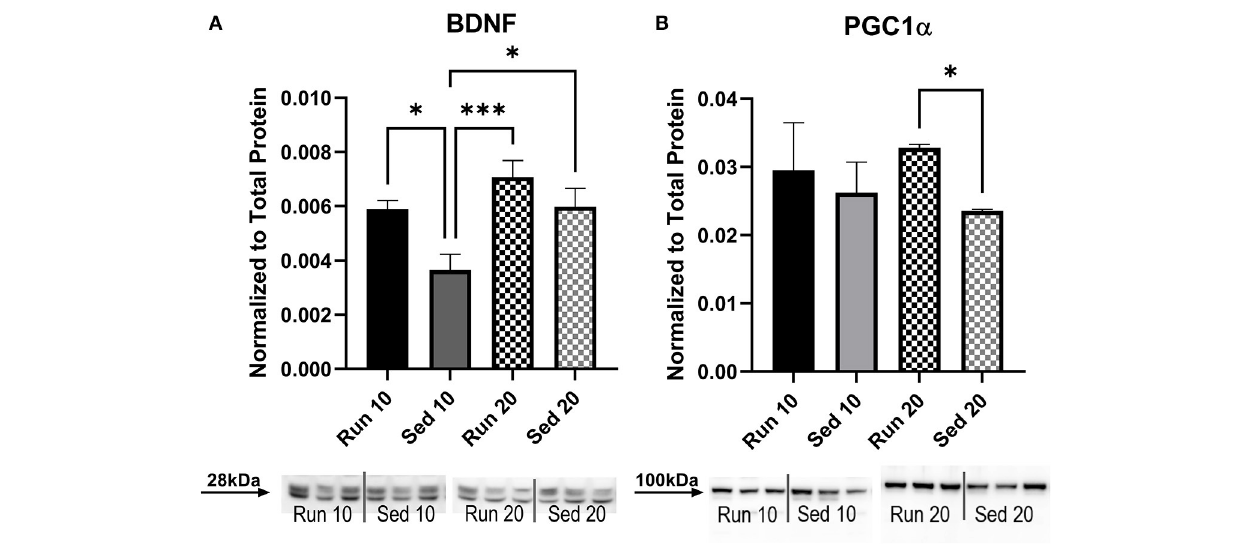
FIGURE 7 | Muscle Protein Expression. A Western blot was used to determine levels of (A) BDNF and (B) PGC1 α in the gastrocnemius muscle. Density of specific bands were normalized to total protein by Sypro Ruby staining (see Supplementary Figure 1 ). No sex differences were present so male and female data were combined. Acute (10 day) and chronic (20 day) changes in protein expression were compared between rathletes (“Run”) and sedentary (“Sed”) rats at these time points. Run 10 = voluntary running wheels for 10 days ( n = 28), Sed 10 = locked wheels for 10 days ( n = 28), Run 20 = voluntary running for 10 days then rested in homecage 10 days ( n = 28), Sed 20 = locked wheels for 10 days then rested in homecage for 10 days ( n = 28). Data are presented as average ± SEM. * p < 0.05, *** p < 0.001.